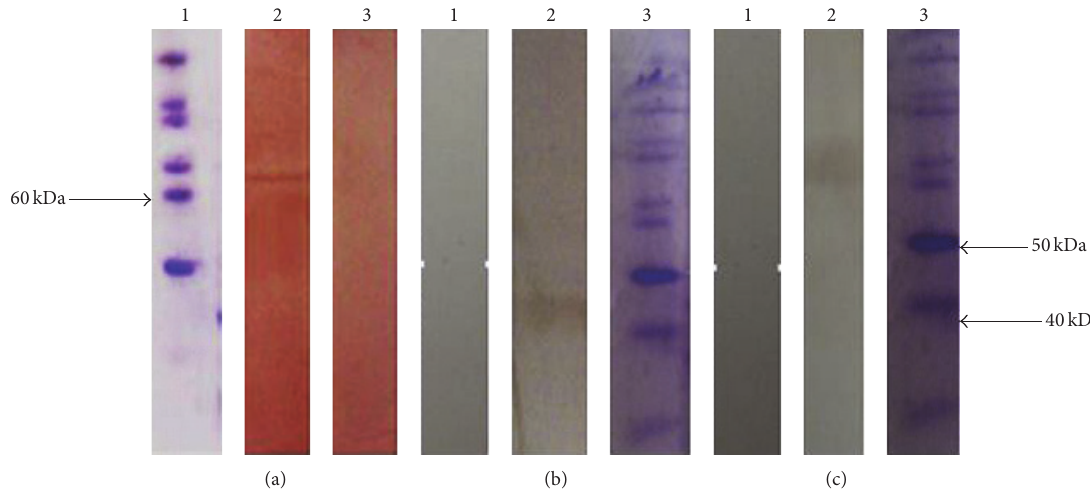
Figure 2: Western blot analysis of the recombinant proteins (a, b, c). (a) lane 1: protein marker (Fermentas); lane 2: interaction between serum of immunized rabbit and purified recombinant FlaA protein. (b) lane 1: protein marker; lane 2: interaction between serum of immunized rabbit and purified recombinant TcpA protein. (c) lane 1: protein marker; lane 2: interaction between serum of immunized rabbit and purified recombinant TcpB protein.